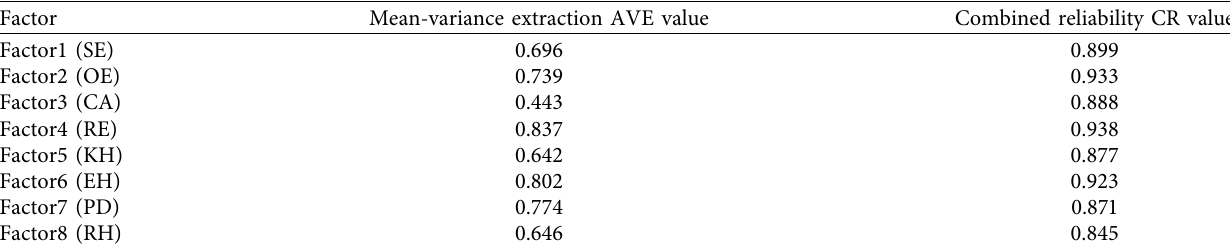
Table 6: Evaluation of the model AVE and CR